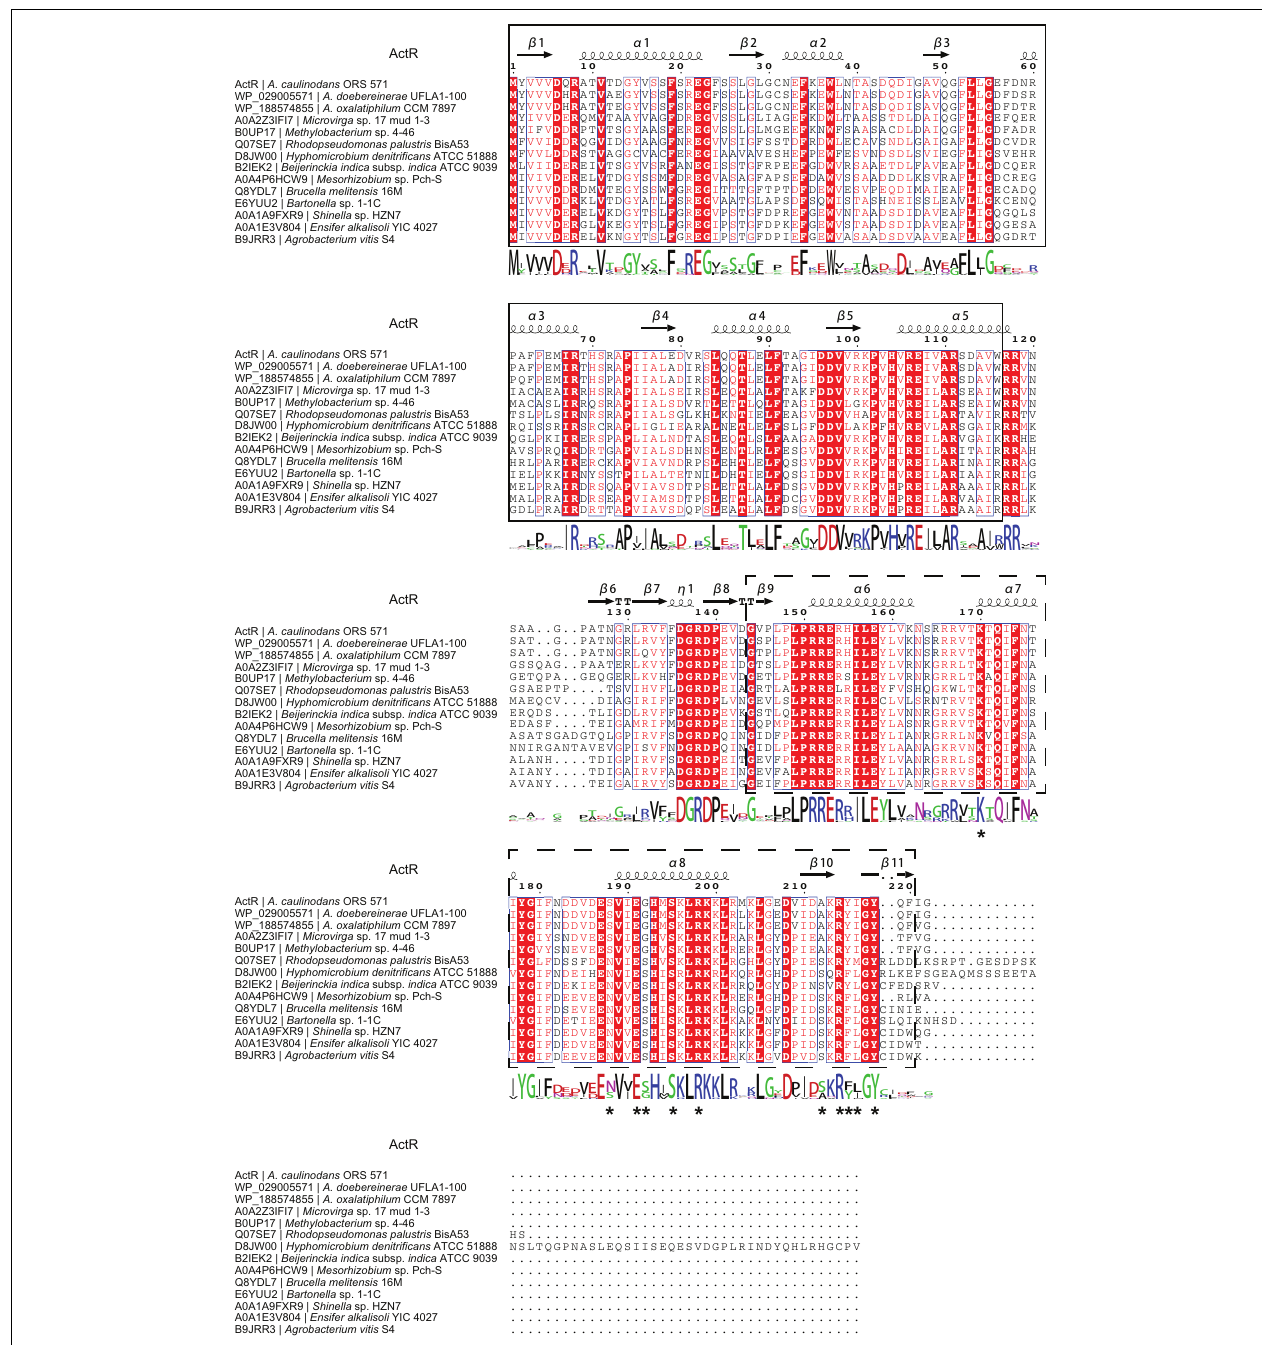
FIGURE 2 | Analysis of the FtcR-like sequence. Protein sequences were aligned using the COBALT with the default parameters. The picture of the alignment was performed by ESPript 3.0. The predicted secondary structure of ActR is shown above the alignment. Conserved residues are shown with red background, and similar residues are shown in red and boxed. The sequence logo is shown below the alignment. The bigger the logo, the more conserved the residue. The ligand binding site residues of ActR predicted by the COFACTOR and COACH programs in I-TASSER are marked with asterisks. The solid line frame and the dashed line frame indicate the response regulator domain and the transcriptional regulatory domain (OmpR/PhoB-type) as recognized in InterPro annotation.